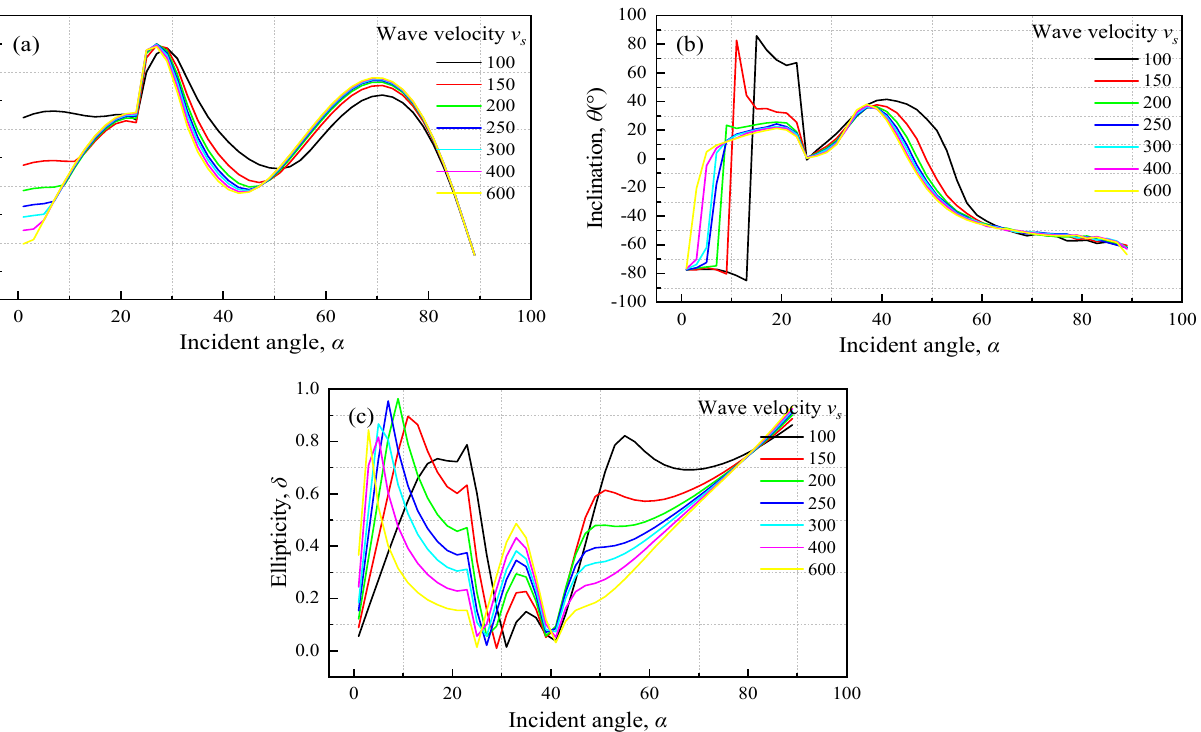
Figure 9. Variation of characteristic parameters of elliptical stress path with the incidence angle for various wave velocity.